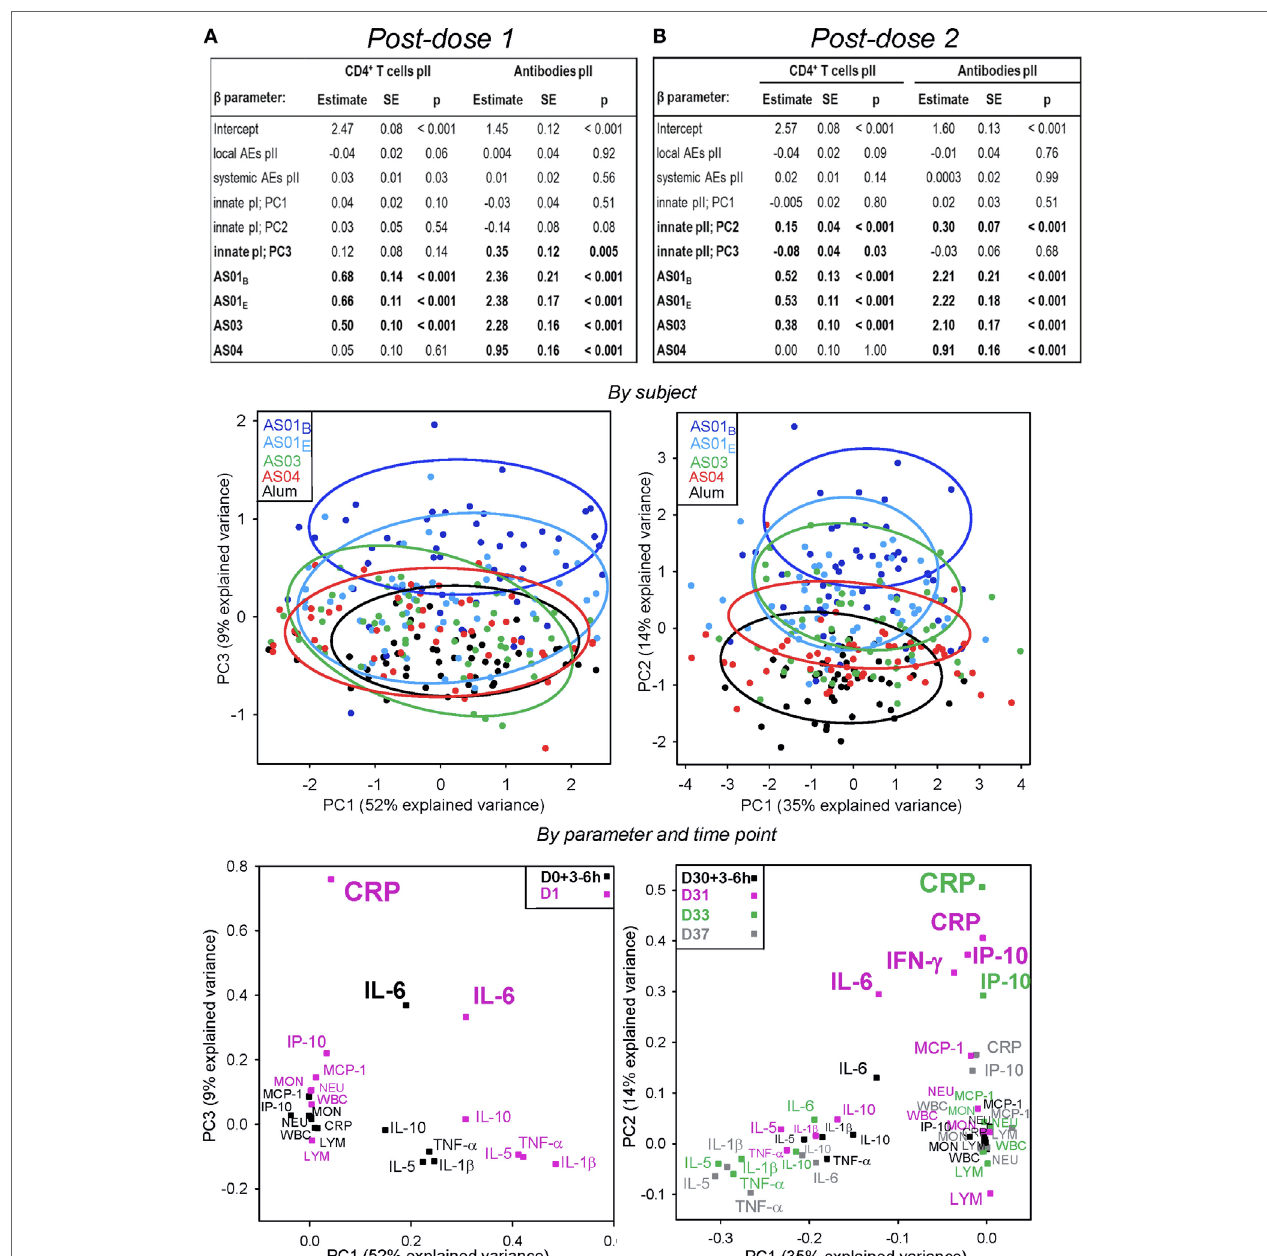
FiGUrE 4 | Associations between adaptive responses, and both the innate responses of hematology, C-reactive protein (CRP) and serum protein variables, and reactogenicity. Participants received HB surface antigen adjuvanted with AS01 B , AS01 E , AS03, AS04, or aluminum salt (Alum; N = 53, 53, 52, 51, and 47, respectively) at days 0 and 30. Data obtained after the first (pI) or the second injection (pII) are shown in panels (a,b) , respectively. Upper panels: multi-parametric analyses of adaptive responses were performed for each coefficient ( β ) of the listed model input parameters, in terms of the estimate of the effect size, standard error (SE), and p -value ( p ). Input parameters included local and systemic reactogenicity scores calculated from the solicited adverse events (AEs) pII, and the innate responses pI and pII. Intercept, β for Alum group ( β 0 ). Adjuvant systems (AS) groups were compared with the Alum group (considered as baseline). HBs-specific CD4 + T-cell and antibody responses were measured at day 44. Principal components (PCs) that were significantly associated ( p < 0.05) with the adaptive response are indicated by bold font. Middle panels: PC analysis of the innate response dataset was performed by subject and treatment group and visualized in bivariate plots. The variance explained by the first three PCs was 73% after the first injection and 58% after the second injection. Each dot represents the expression profile of an individual subject. Arbitrary aggregation of the subjects into treatment groups is visualized by the colored ellipses, according to the color coding presented in the left-hand corners of the plots. The PC1 accounted for 52 and 35% of the variance after the first and second dose, respectively, and is plotted against the PCs showing the strongest association with the adaptive response in the table in the upper panels, i.e., the PC3 after the first dose and the PC2 after the second dose. Lower panels: as for the middle panels, but with PCs representing the variables at the post-vaccination time-point indicated by the color coding in the upper corners of the PC plots. An overview of PC plots for each PC1, PC2, PC3 combination by variable/time-point is presented in Figure S3 in Supplementary Material. LYM, lymphocytes; MON, monocytes; NEU, neutrophils; WBC, white blood